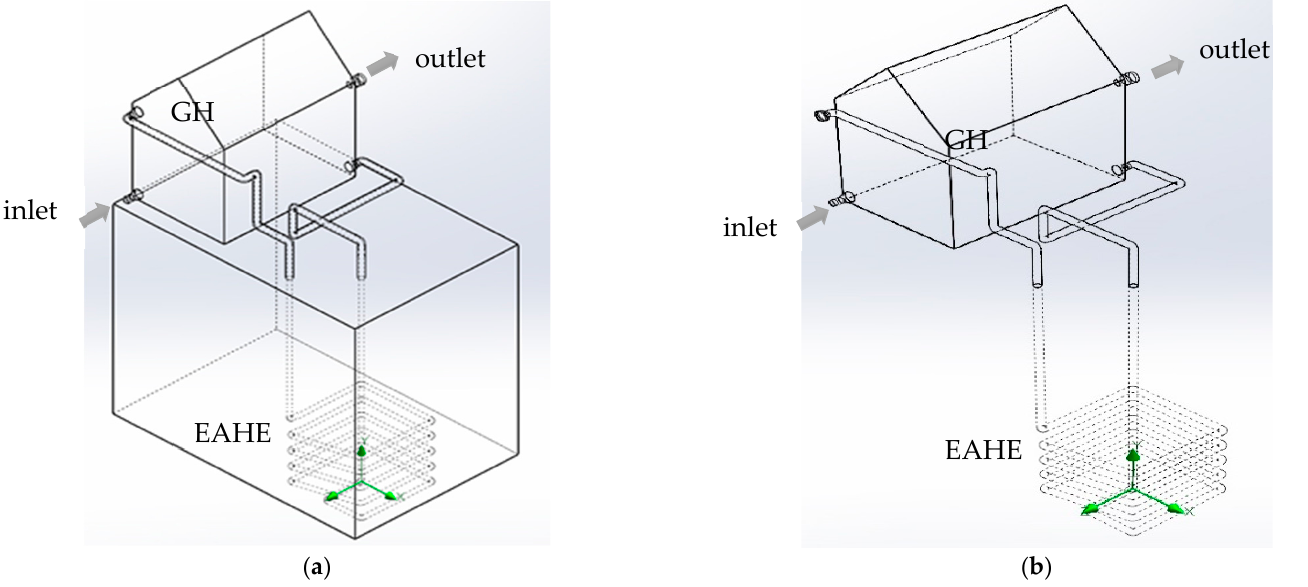
Figure 2. Path of the air exchange in the two models. ( a ) Closed-loop schematics. ( b ) Open-loop schematics.